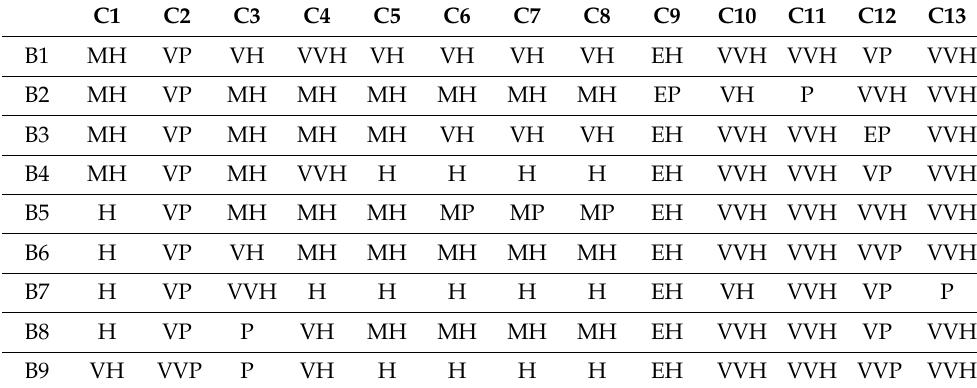
Table A1. Assessment of alternatives by E1.